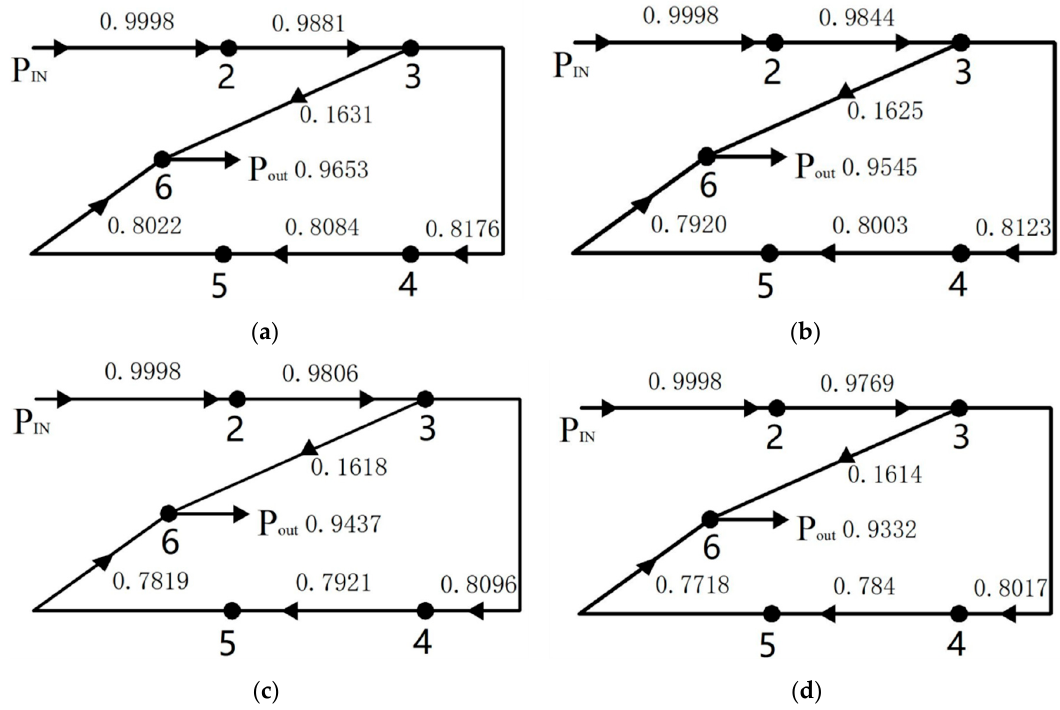
Figure 9. Flowchart of gear drive power loss calculation process .